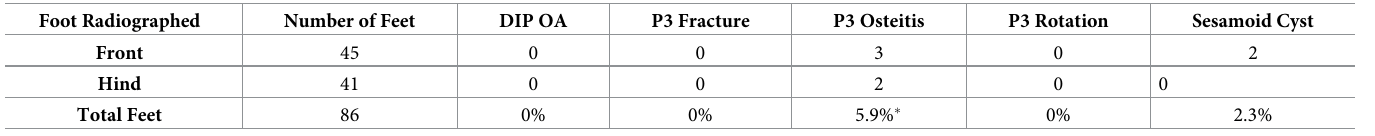
Table 1. Radiographs demonstrated that foot pathologies were uncommon in these young adult free-ranging